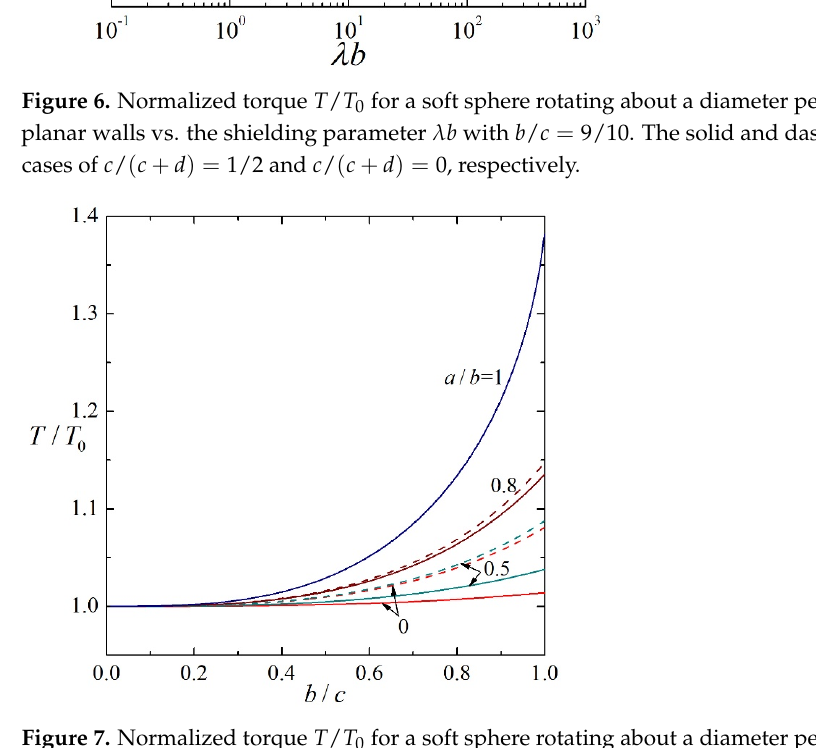
Figure 7. Normalized torque T / T 0 for a soft sphere rotating about a diameter perpendicular to two planar walls vs. the spacing parameter b / c with c / ( c + d ) = 1/2. The solid and dashed curves denote cases of λ b = 1 and λ b = 3, respectively.